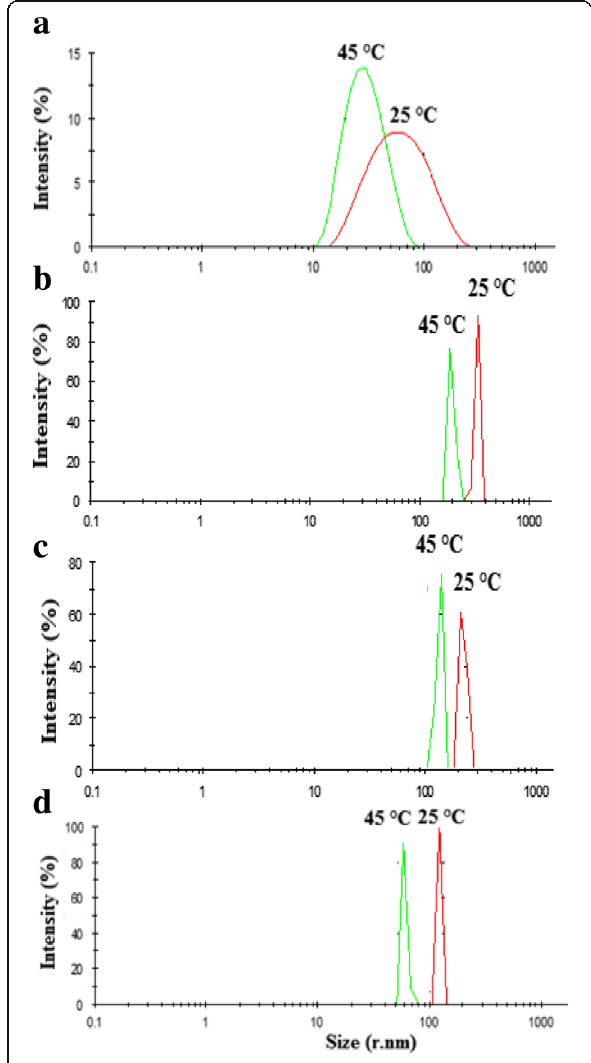
Fig. 3 Dynamic light scattering below (25 °C) and above (45 °C) the lower critical solution temperature phase transition for PNIPAAm ( a ), Fe 3 O 4 -PNIPAAm-1 ( b ), Fe 3 O 4 -PNIPAAm-2 ( c ) and Fe 3 O 4 -PNIPAAm-3 ( d